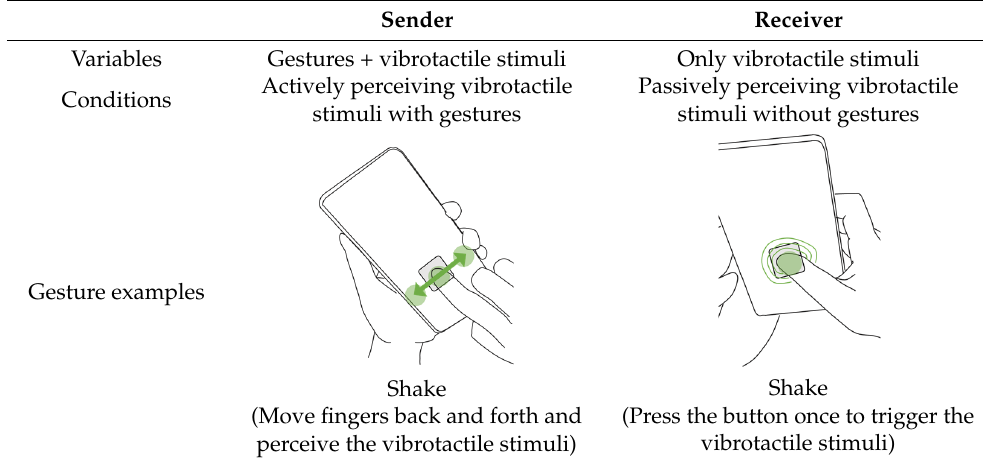
Figure 3. Test environment. Table 2. Variables and test